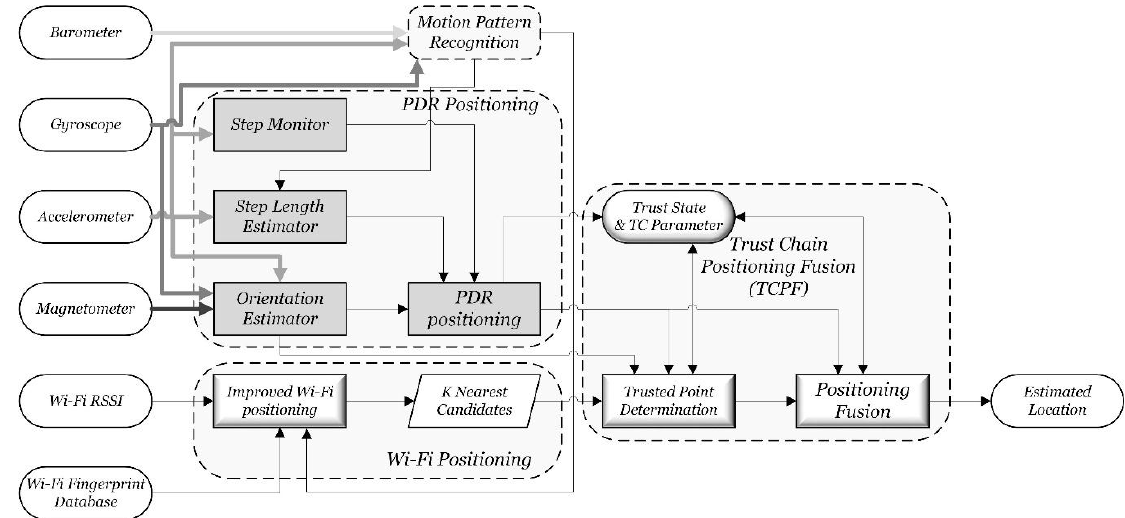
Figure 4. Algorithm framework of indoor continuous positioning.